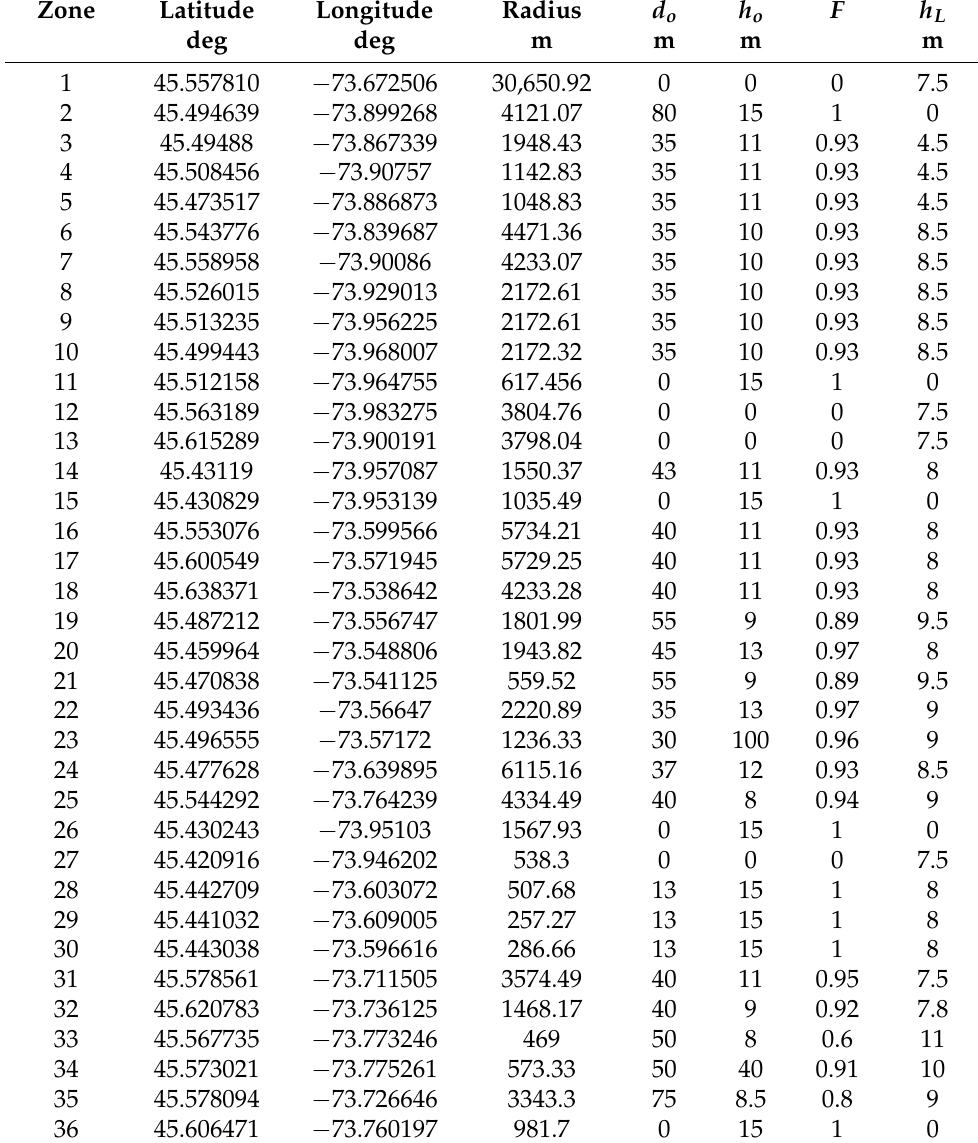
Table A1. Subgrid obstacles parameters and lamp heights used to model Montréal. The 309 zones were selected in order to define regions with relatively constant